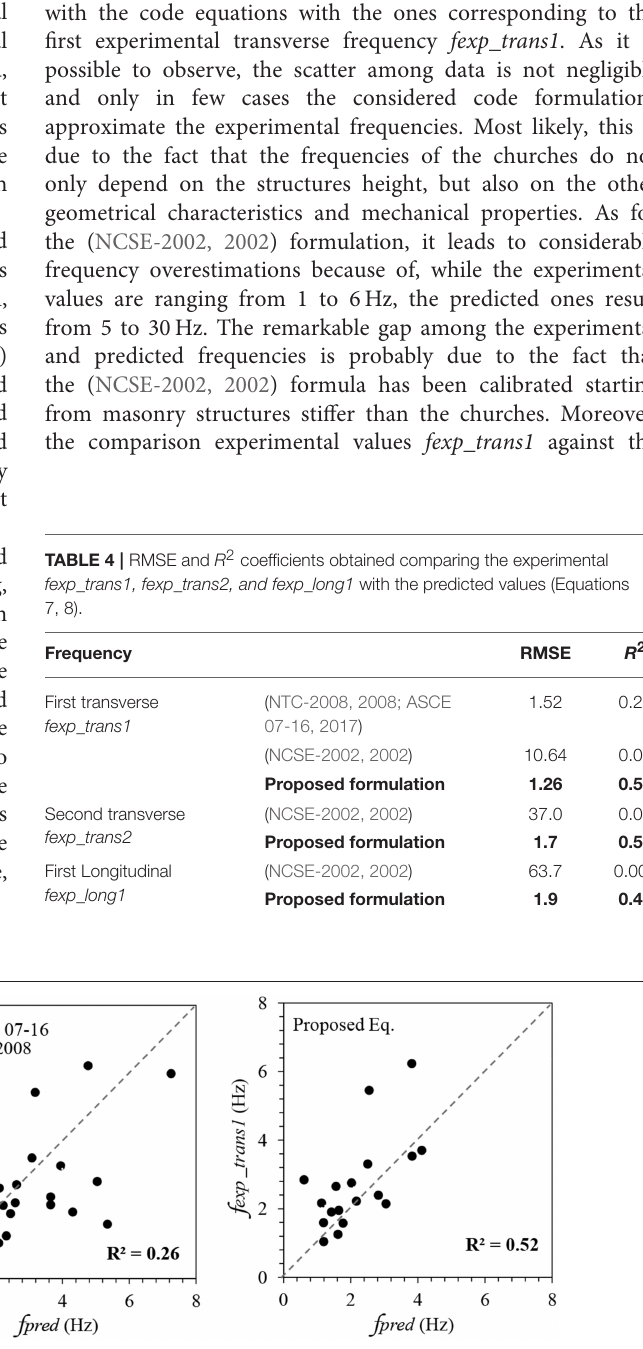
FIGURE 8 | Comparisons among the experimental fexp_trans1 and the predicted fpred , by referring to the formulation adopted by: (A) ASCE 07-16 (2017), (B) NTC-2008 (2008), and NCSE-2002 (2002), (C) proposed formulation.